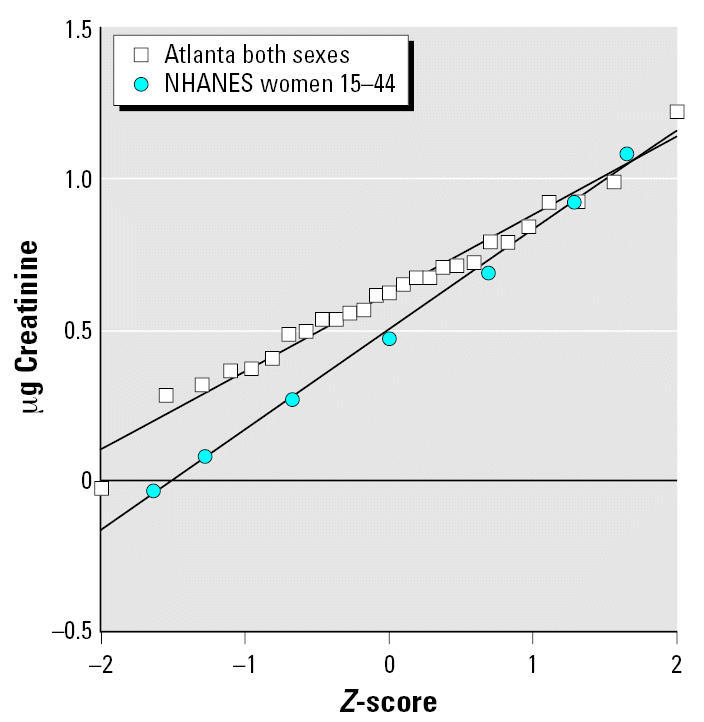
Comparison of urinary perchlorate (μg/g creatinine) between Atlanta sample of 27 adults versus national sample of women 15–44 years of age. Atlanta: y = 0.622 + 0.258x; R2 = 0.974. NHANES: y = 0.498 + 0.332x; R2 = 0.997.